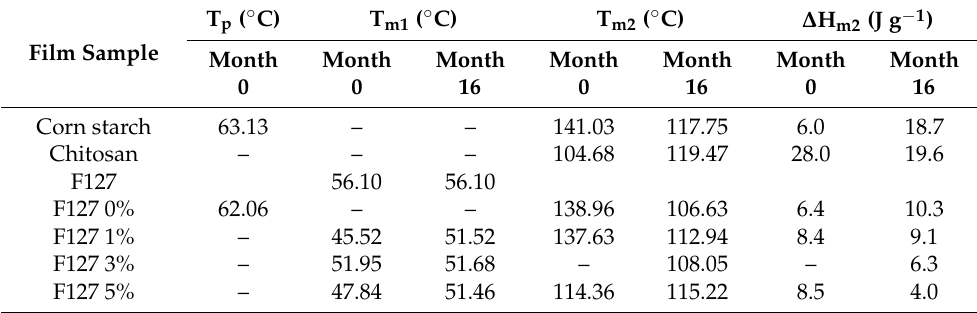
Table 2. DSC parameters of biodegradable films of corn starch-chitosan with pluronic F127 at ratios of 0%, 1%, 3%, and 5% stored for 0 and 16 months.